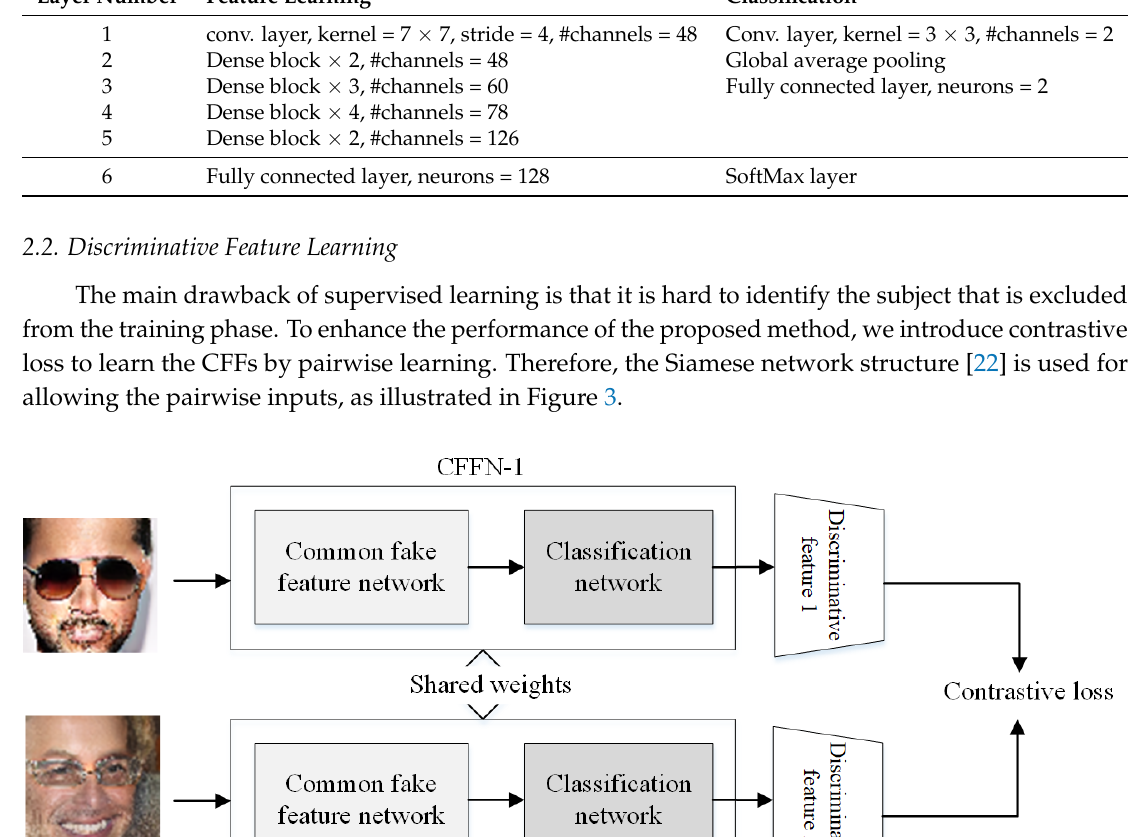
Table 1. Structure Parameters of the Proposed Common Fake Feature Network for Fake Face Image Detection. Layer Number